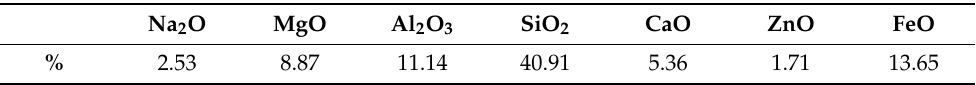
Table 1. Oxide composition of the DM material from ED X-Ray Fluorescence (XRF) analysis. Na 2 O